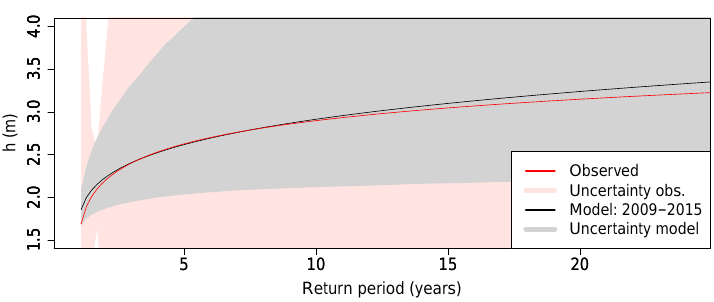
Figure 7. Unconditional model. Return levels of the impact h with associated 95% uncertainty intervals. The return level computed on h obs is shown in red (uncertainty shown in light red). The model-based return level is shown in black (uncertainty is in